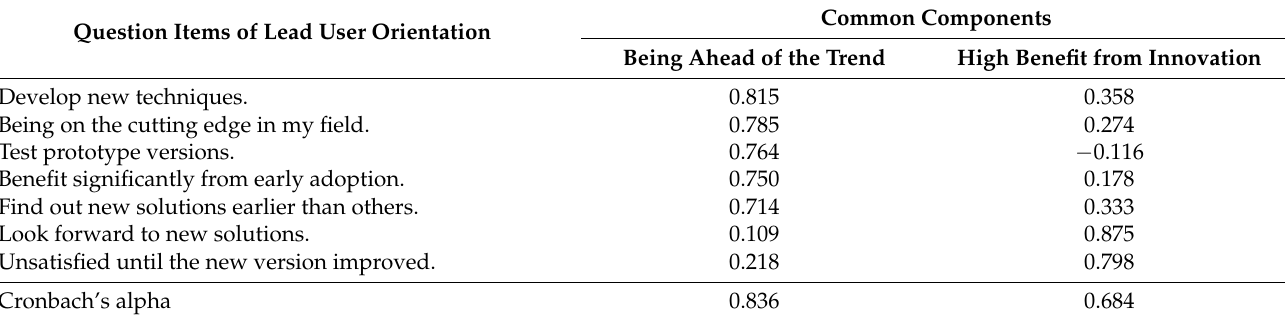
Table 5. Validity and Reliability analysis for measuring characteristics of leader